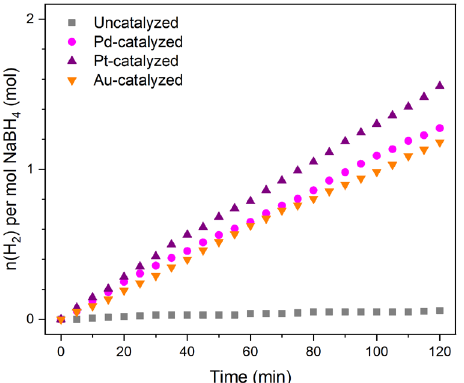
Figure 1. H 2 evolution curve for the hydrolysis of 2 mL of an aqueous alkaline (0.1 M NaOH) solution of BH 4− (0.66 M; i.e., 50 mg NaBH 4 in 2 mL) catalyzed by 16.1 mg of Pd, 14.5 mg of Pt, or 14.3 mg of Au at 30 °C. The H 2 evolution curve for the uncatalyzed hydrolysis test is also shown. The y -axis has been limited to the range 0–2 for clarity.